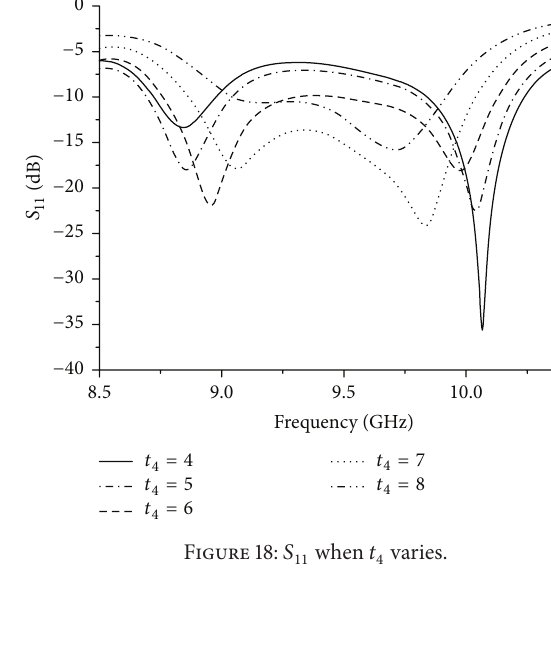
Figure 18: 𝑆 11 when 𝑡 4 varies.